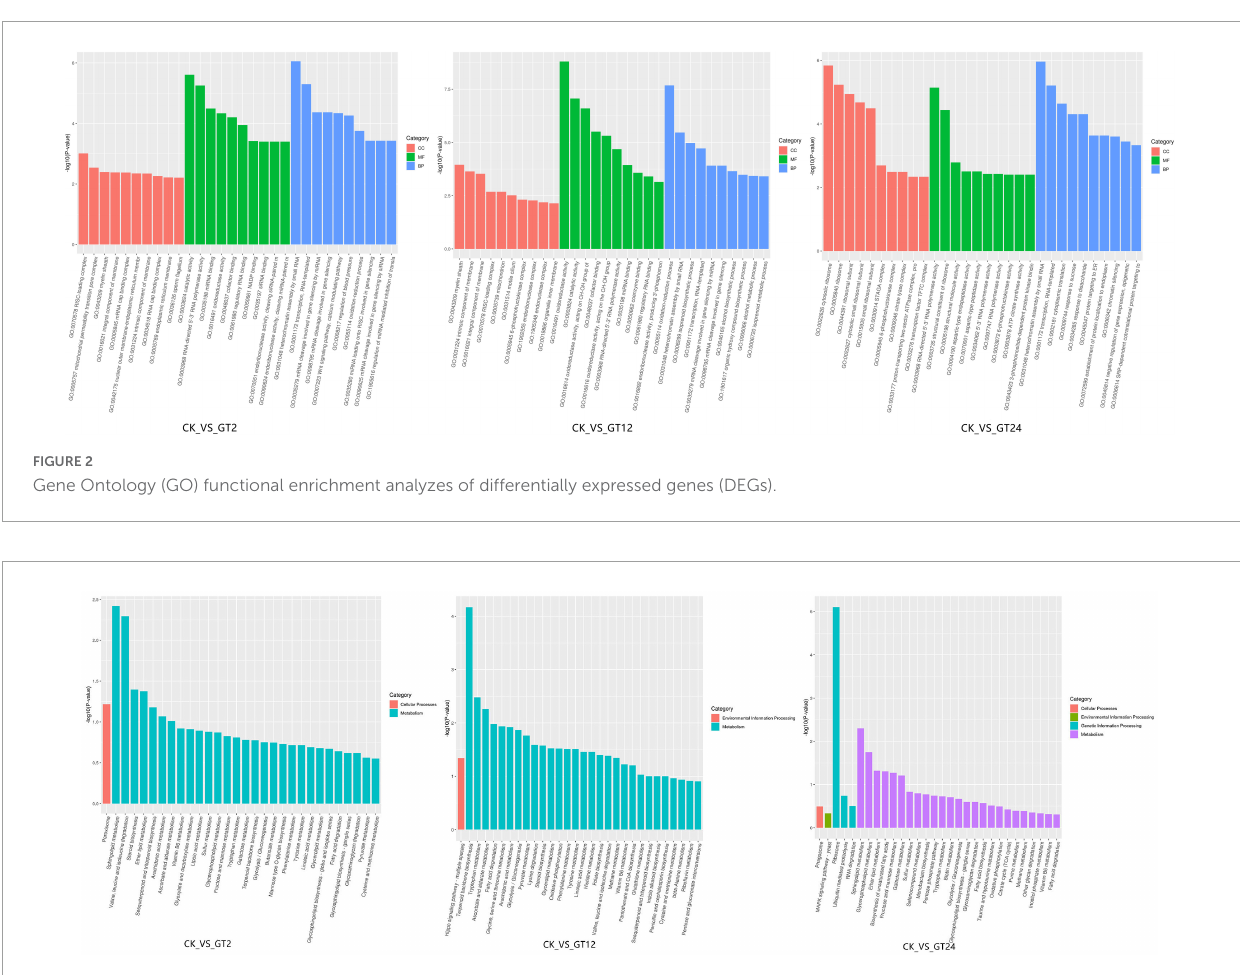
Frontiers in Microbiology